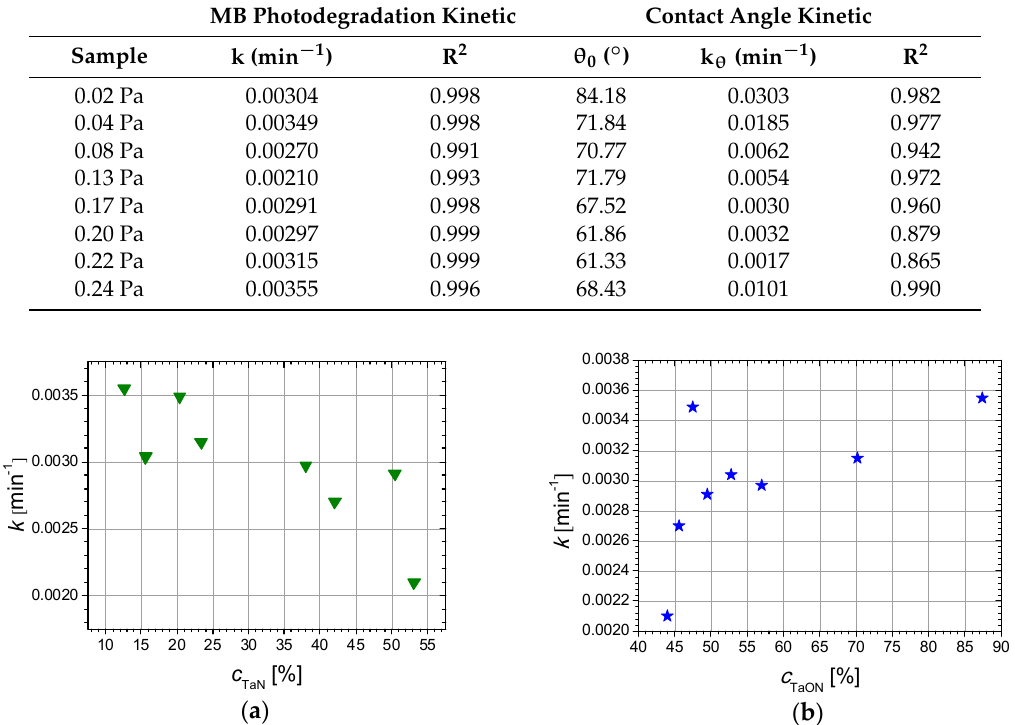
Figure 14. Contact angle kinetic of the films under UV irradiation. With the increase of the reactive gas flow, the films become less metallic and the contact angles tend to decrease, due to the formation of more hydrophilic oxygen-rich species on the surface of the samples (TaO x N y , Ta 2 O 5 ). For all the films, the contact angles decrease considerably after UV irradiation (with 40–73%), possibly due to the formation of oxygen vacancies on the surface of the materials, which in turn can photocleave the adsorbed water molecules, leading to transient surface hydroxyl groups, of the Ta-OH type [61–64]. The contact angle kinetic was fitted against an exponential dependency of time, described by Equation (11): 𝜃 = 𝜃 (cid:2868) ⋅ 𝑒 (cid:2879)(cid:3038) (cid:3335) ⋅(cid:3047)